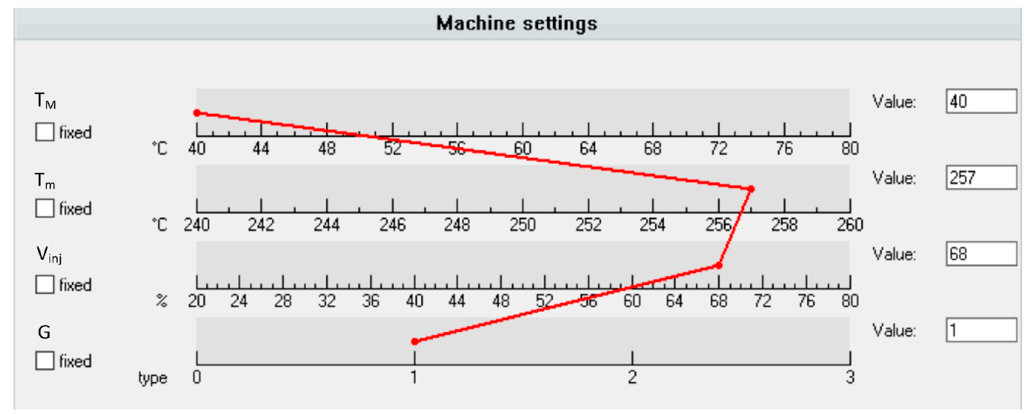
Figure 10. Optimized parameters by STASA QC: T M —mold temperature, T m —melt temperature, V inj —injection rate, G —geometry .